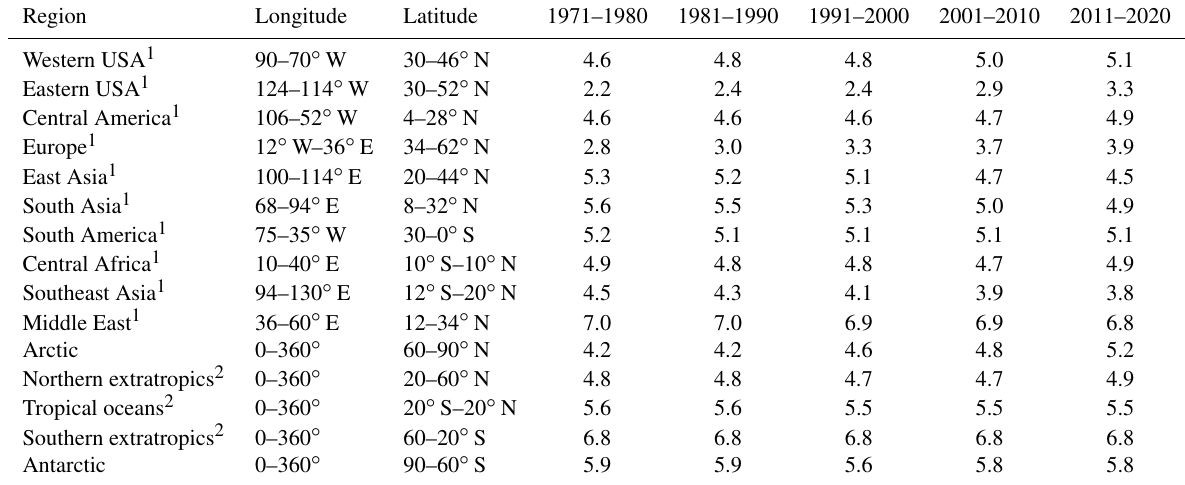
Table 1. Decadal averages of aerosol particle pH.